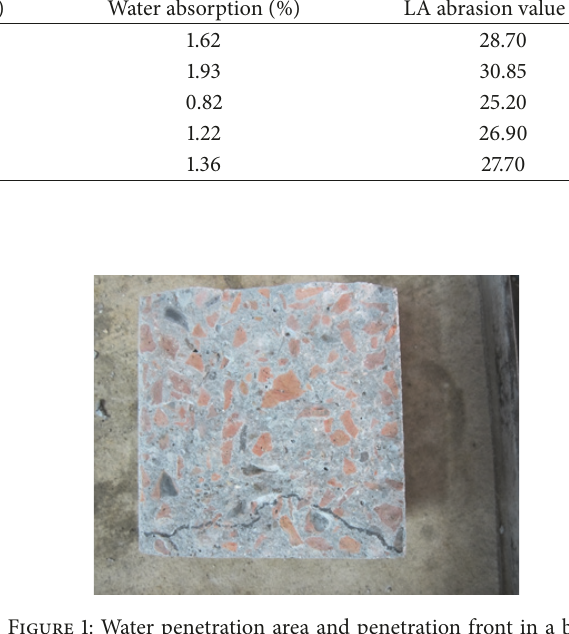
Figure 1: Water penetration area and penetration front in a brick aggregate concrete